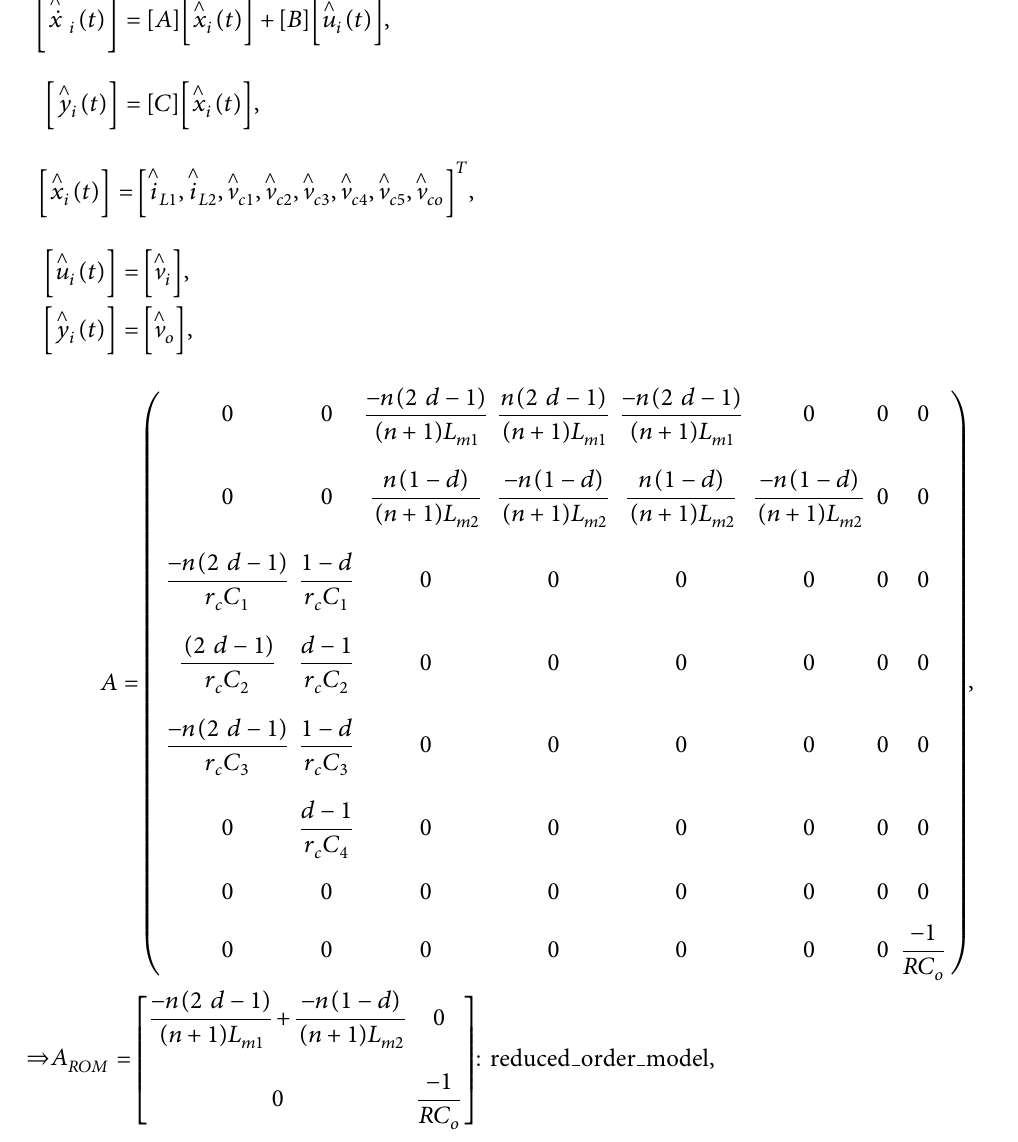
equations are achieved in one switching period, regardless of the small intervals, and in the modes where S the form of [ON ON, ON OFF, OFF ON]. According to equation (51), the state variables are the current of inductors and voltage of capacitors. The arrays of matrices A , B , and C in equation (50) are given in equations (51). The vector of input and output variables is also given in equation (51). The weight coefficients for three switching states in the state matrix are as follows: (1 − d ), (2 d − 1), and (1 − d ). . Also, state-space c